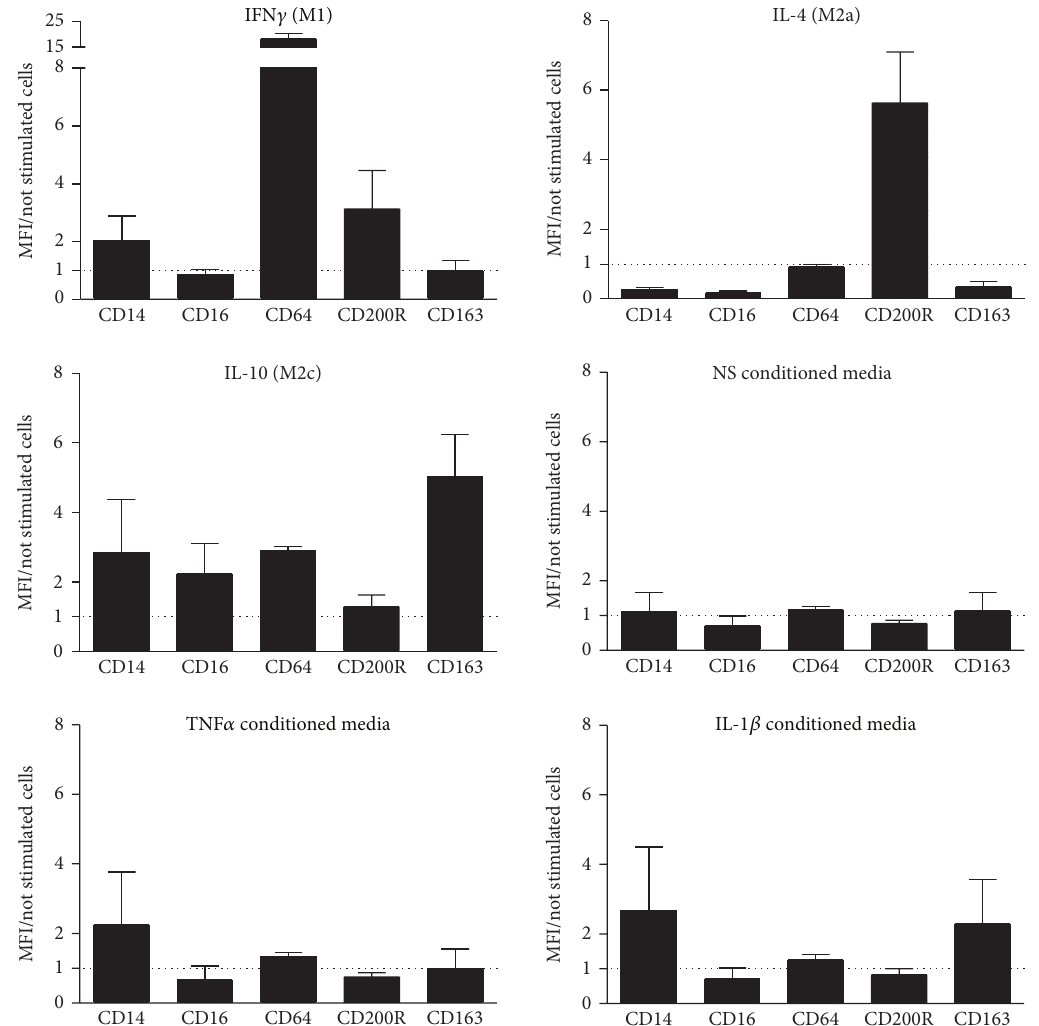
Figure 4: SF conditioned media do not regulate the expression of typical M1 or M2 surface markers . CD14+ monocytes were cultured 4 days in presence of medium with 10% FBS without (not stimulated cells) or with IFN 𝛾 (50ng/mL; M1) or IL-4 (50ng/mL; M2a) or IL-10 (50 ng/mL; M2c) or RA SF conditioned media. FACS analysis of the cell surface markers for classical (CD14), nonclassical (CD16), M1 (CD64), M2a (CD200R), and M2c (CD163) macrophages was thus performed. Values are expressed as the ratio of the mean fluorescence intensity (MFI) of the marker on the stimulated cells over MFI of unstimulated cells. Bars represent the mean ( ± SEM) of 3 independent experiments.